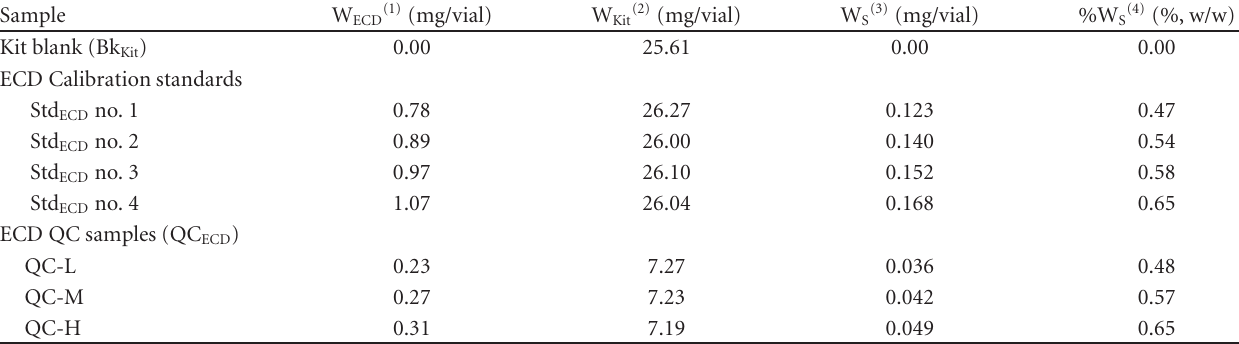
Table 2: Preparation and composition of ECD calibration standards, blank, and quality control samples. Sample